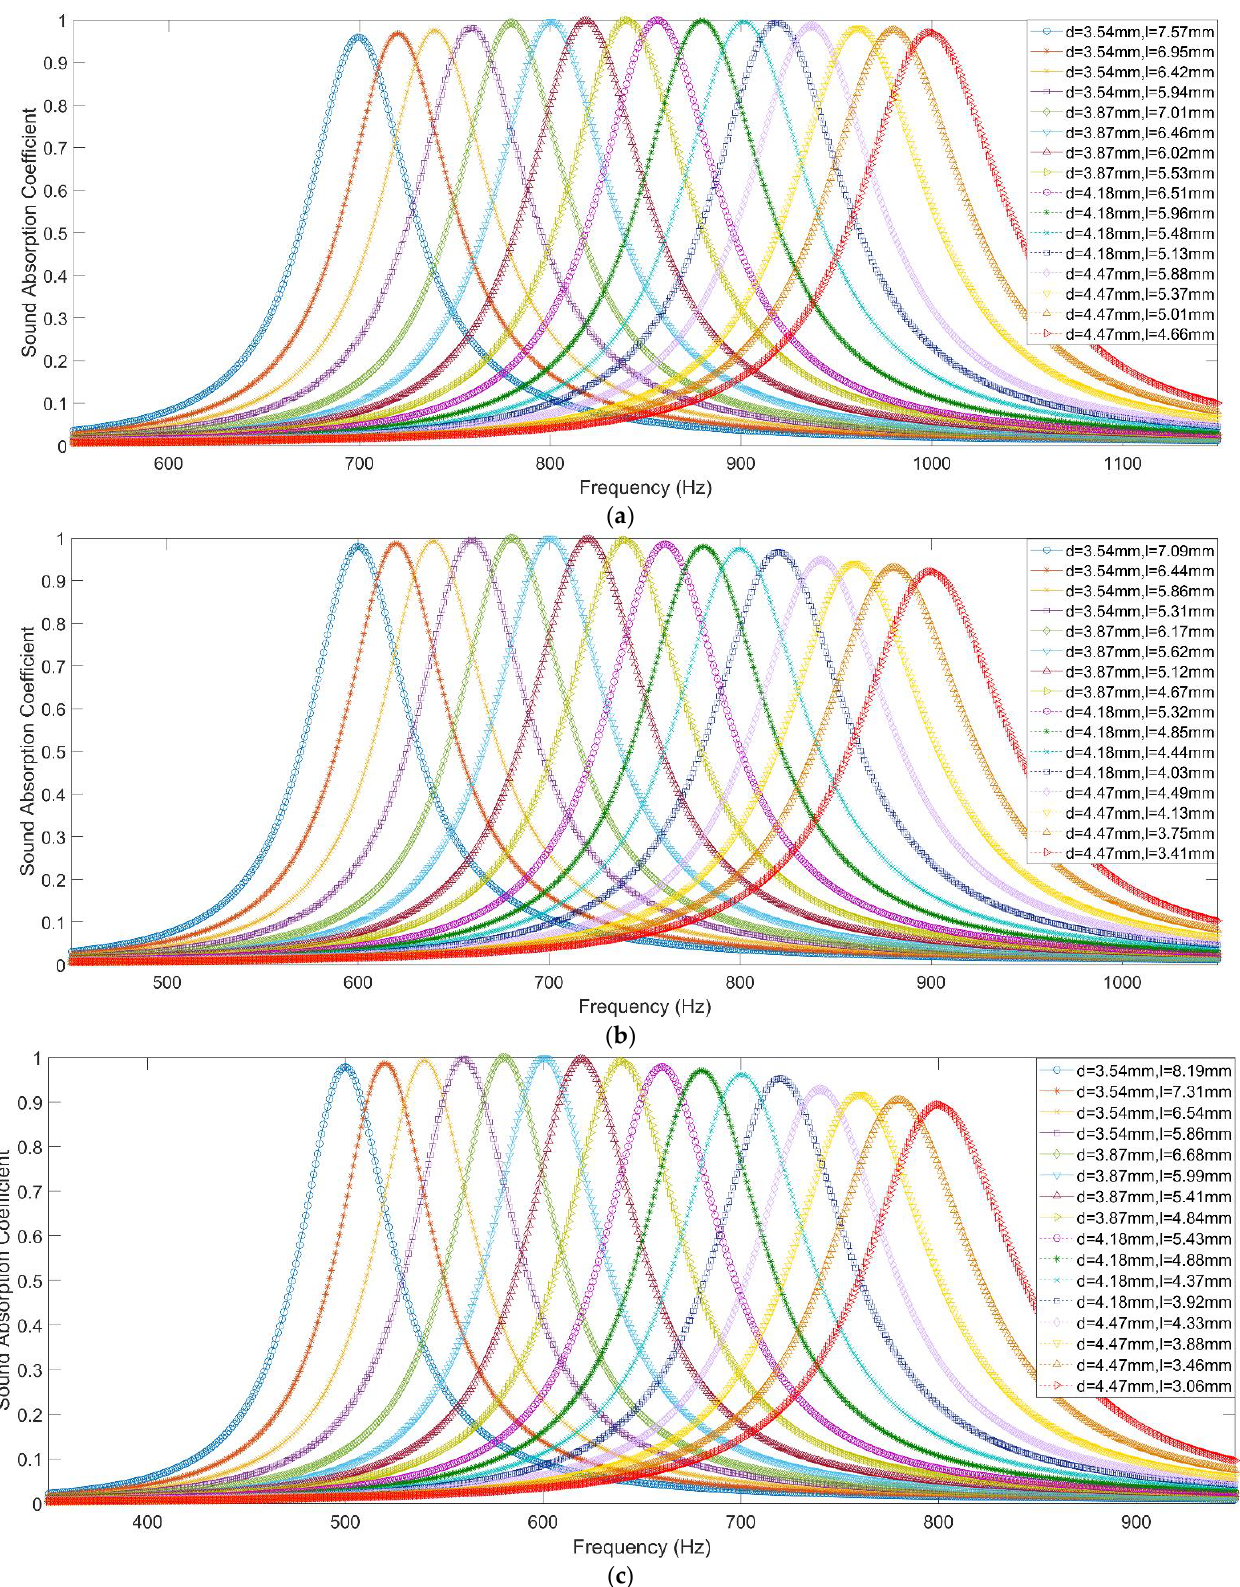
Figure 6. Distributions of sound absorption coefficients of each single resonator for the three conditions with initial values of parameters: ( a ) Condition − 1; ( b ) Condition − 2; ( c ) Condition − 3.